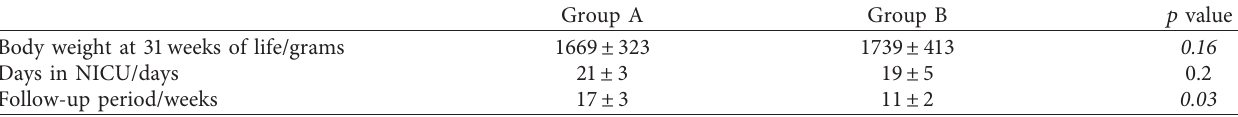
Table 1: The mean body weights at 31weeks of life, days in NICU, and follow-up periods and p values.